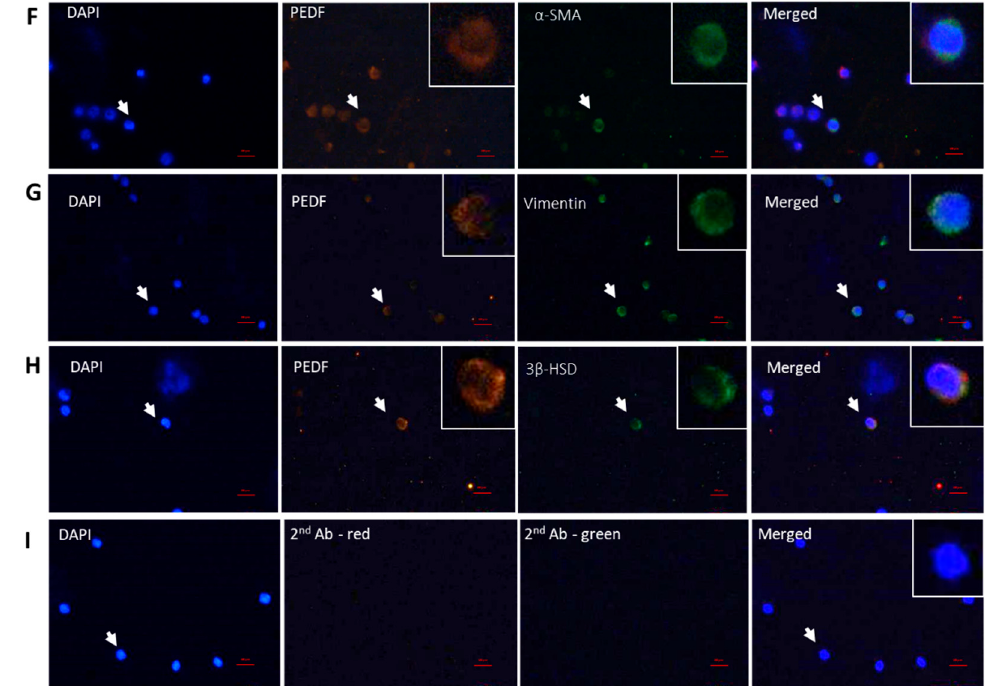
Figure 2. Cellular localization of PEDF in testicular somatic cells. Paraffin embedded testicular tissue from 6-week-old mice were sliced, fixed on slides and immunofluorescence double stained for DAPI (blue), PEDF (red) and for testicular somatic cells markers (green): ( A ) α -SMA (peritubular cells marker), ( B ) vimentin (Sertoli cells marker), ( C ) tubular NC—without primary antibody, ( D ) 3 β -HSD (Leydig cells marker), ( E ) interstitial tissue NC—IF staining without the presence of primary antibody. In addition, methanol-fixed isolated testicular cells were immunofluorescent double stained for: ( F ) α -SMA, ( G ) Vimentin and ( H ) 3 β -HSD. ( I ) NC—IF staining without the presence of primary antibody. Scale bar: 100 μ m.